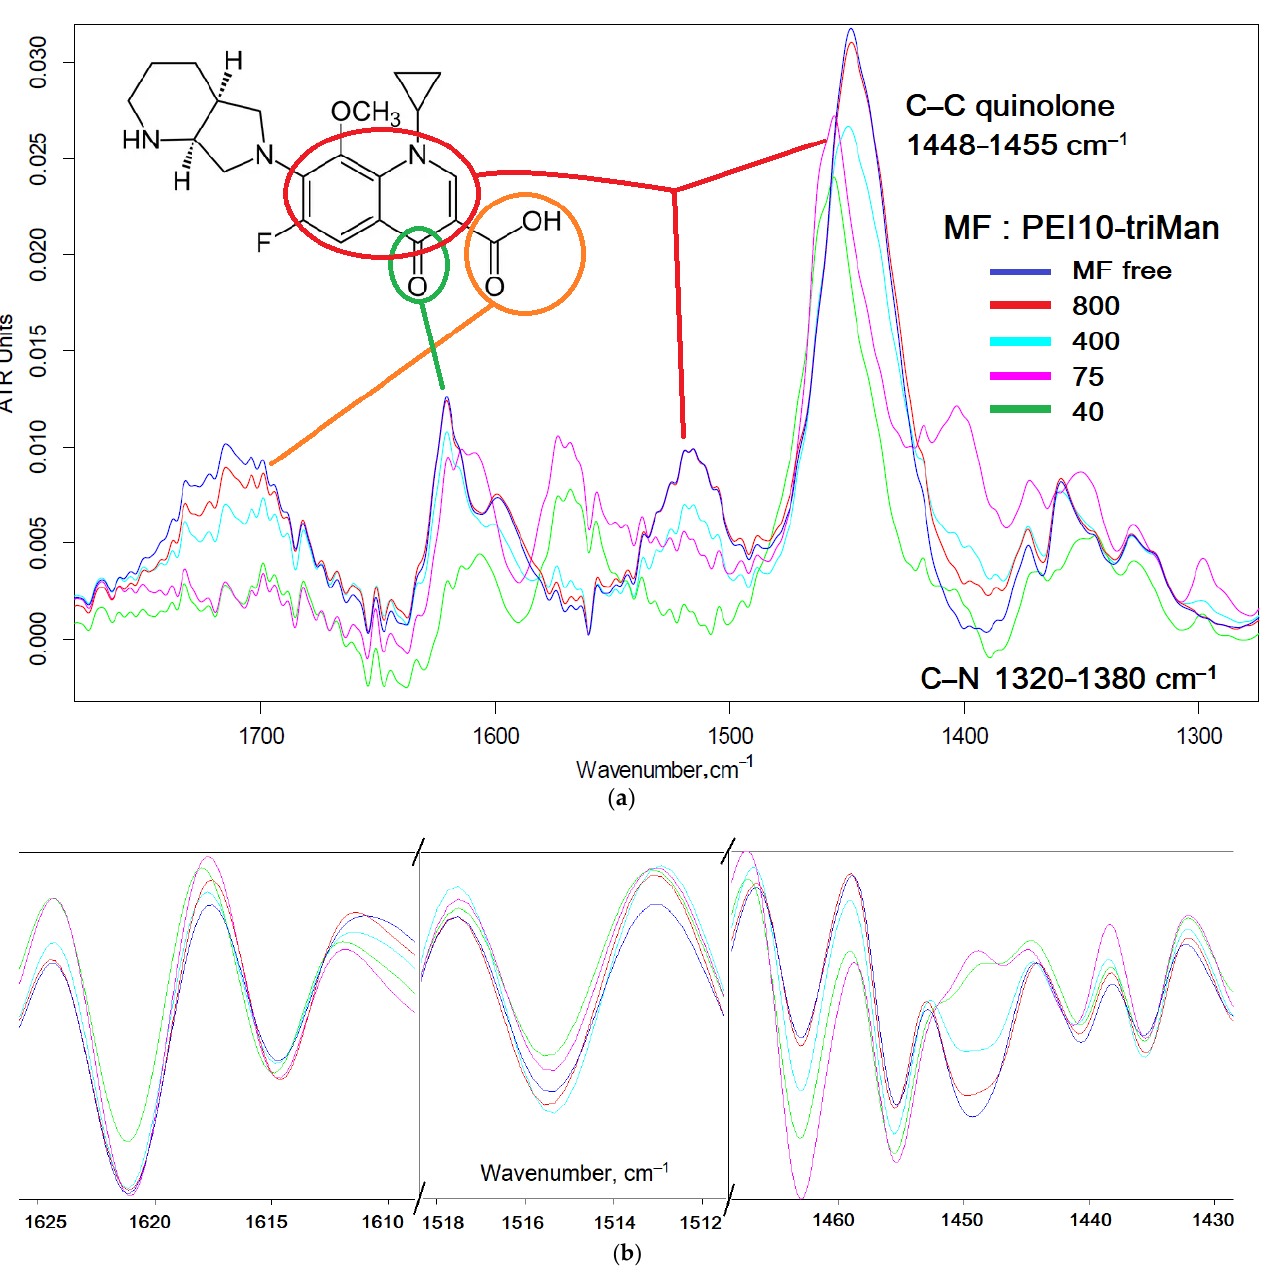
Figure 5. ( a ) FTIR spectra and ( b ) its second derivative (d 2 A/ dν 2 ) of MF and MF complexes with PEI10-triMan. Concentrations in Figure B, such as on A. 0.01M HCl. T = 22 °C. Table 3. Dissociation constants of MF conjugate complexes determined by FTIR spectroscopy. Num- ber of MF molecules held by one conjugate molecule in CD tori (N CD ) and polymer matrix (N polymer ). Entrapment efficiency (EE) and loading capacity (LC) of MF by molecular containers. C ligand_total = 0.0001 M, C MF_total = 0.001M. The conditions are given in the Methods section.